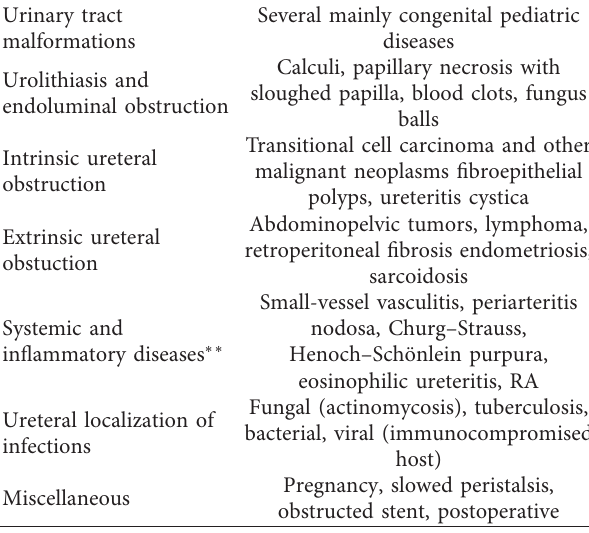
Figure 1: Native CTscan (a) at admission showing massive bilateral hydronephrosis and (b) at 3 months showing a complete regression of the hydronephrosis on the left side and a partial regression on the right side. Table 1: Causes of bilateral or potentially bilateral ureteral obstruction ∗ .